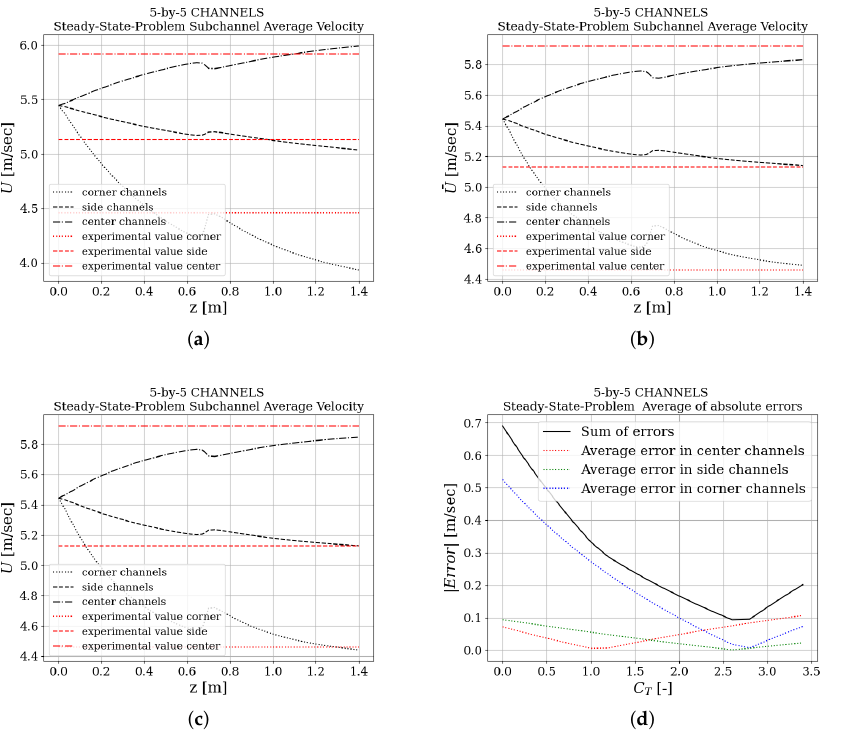
Figure 8. Calibration of C T . ( a ) Velocity distribution for C T = 0. ( b ) Velocity distribution for C T = 3. ( c ) Velocity distribution for C T = 2.6. ( d ) Average absolute error in exit velocity vs. C T .